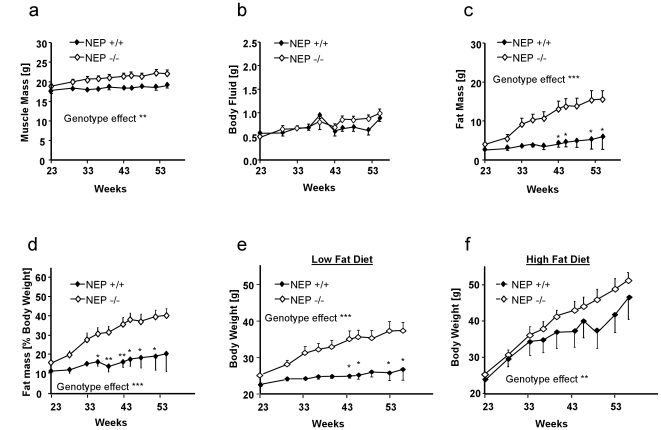
Body composition and diet-depending weight development in NEP-deficient mice.NMR-monitored influence of feeding on age-dependent body composition in mice fed with low fat diet divided in (a) muscle masses, (b) free body fluid, (c) fat masses, and (d) fat masses per body weight. Effects of (e) low fat and (f) high fat diet on the development of body mass. Data is presented as means ± SEM of at least 10 animals per group. Two-way ANOVA **P<0.01; ***P<0.001. Where not shown, error bars lie within the dimensions of the symbols. Genotype effects are calculated by two-way ANOVA (**P<0.01; ***P<0.001). Significant differences at specific time-points are calculated by Bonferroni post-hoc test, *P<0.05 and **P<0.01.